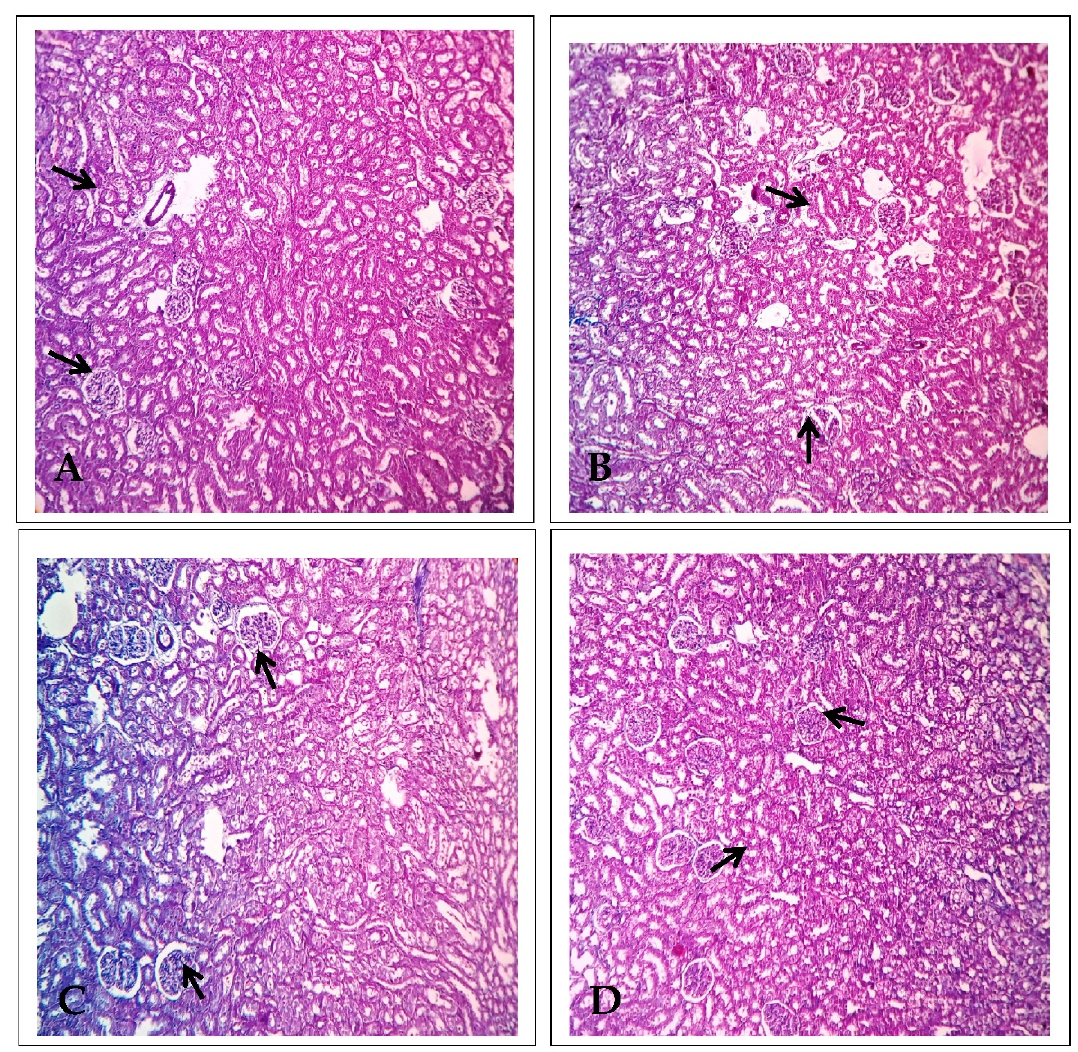
Figure 3. Histopathology of the kidney using Masson’s trichrome stain ( n = 6) (100× magnification). ( A ) Control kidney shows well-defined glomeruli with a Bowman‘s capsule and renal tubules. ( B ) Lead acetate (PbA; 30 mg/kg body weight (b.w.)) treated kidney shows shrunken glomeruli with a dilated Bowman‘s capsule and degenerated renal tubules. ( C ) N -acetylcysteine (NAC; 200 mg/kg b.w.) + PbA (30 mg/kg b.w.) treated kidney shows renal glomeruli and cortical tubules. ( D ) Ethanolic extract of Celastrus paniculatus seeds (EECP; 800 mg/kg b.w.) + PbA (30 mg/kg b.w.) treated kidney shows normal glomeruli having a well-structured Bowman’s capsule as well as distal and proximal convoluted tubules.